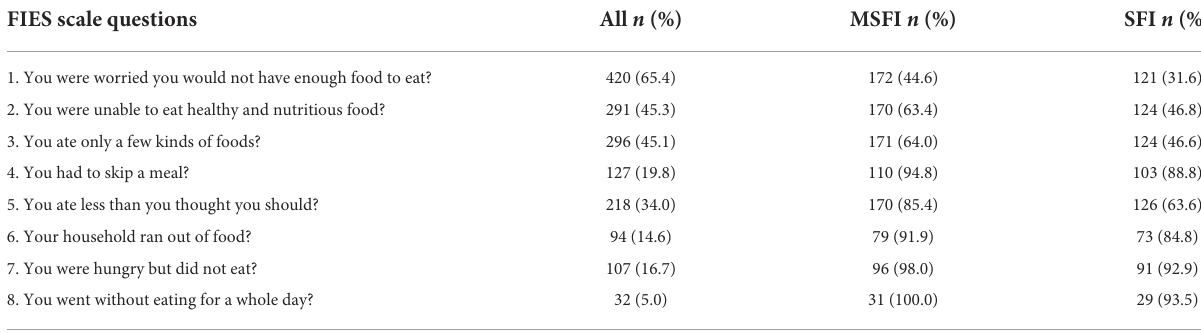
TABLE 3 Distribution of the affirmative answers (yes) to the questions on the FIES scale according to the perception of Moderate-Severe Food Insecurity (MSFI) or Severe Food Insecurity (SFI) in the household.